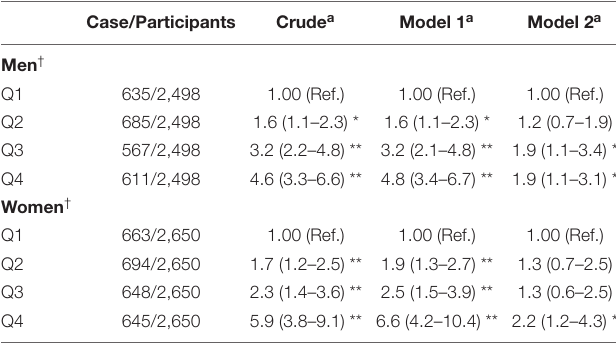
(Men = 2,498, women = 2,650).